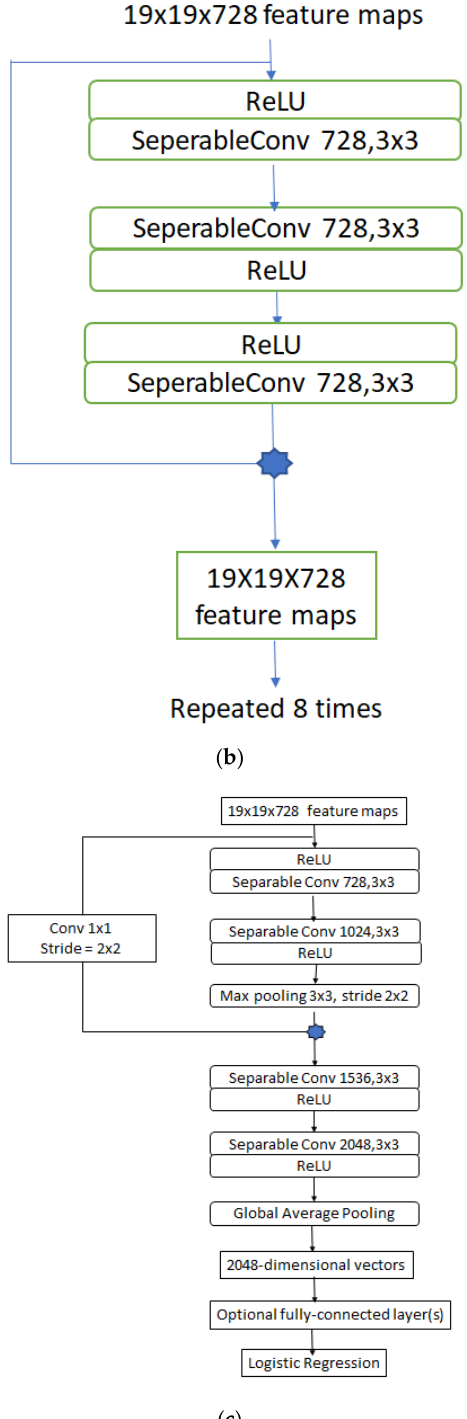
Figure 8. ( a ) The architecture of Xception entry flow; ( b ) the architecture of Xception middle flow; ( c ) the architecture of Xception exit flow.